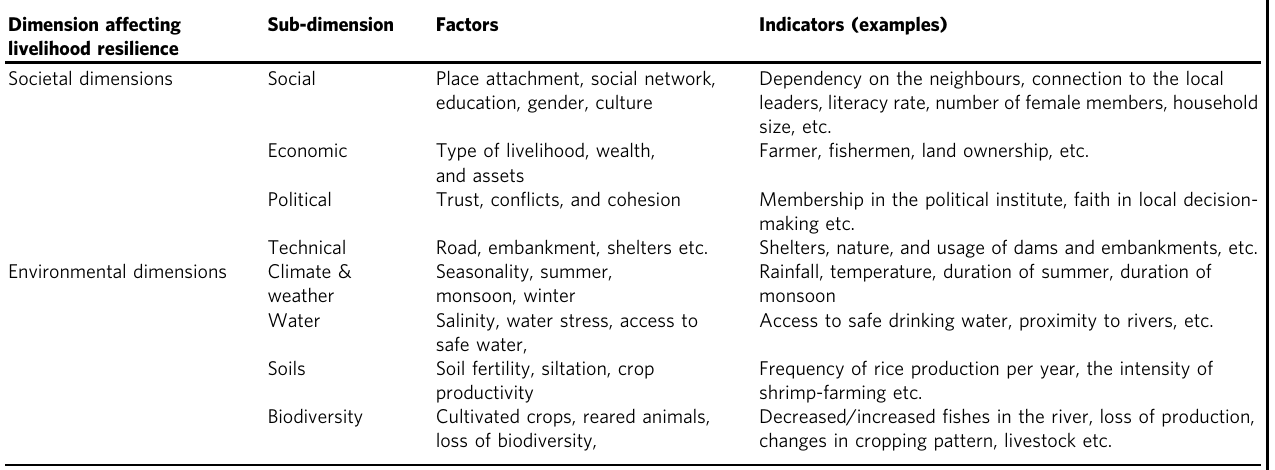
Table 1 Examples of factors and indicators of the livelihood resilience of an individual household and their relevance to environmental